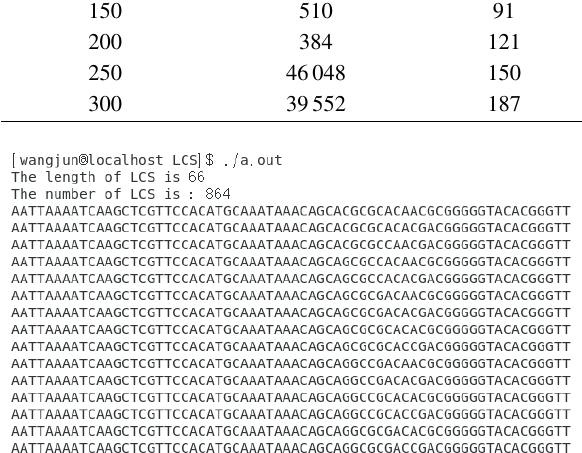
Fig. 6 Experimental result of LCS assembly